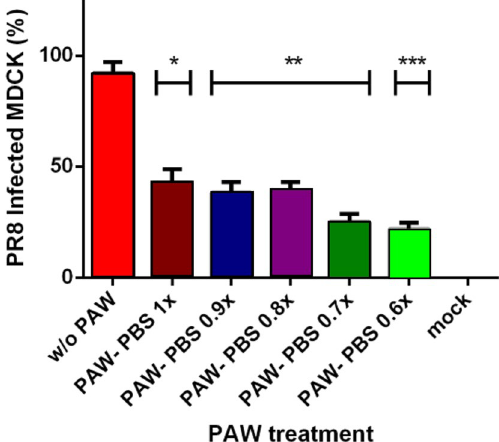
Figure 6. Counting of infected cells with PR8 without and with different PAW-PBS dilutions. Cells were infected with a MOI of 0.25 for 1 h, then submitted to the different treatments, and led the progression of the infection for 24 h. Immunofluorescence was carried out as described in methods and final counting of infected cells versus non-infected cells. Infection was reduced by more than a half (53%) with the lowest dilution of PAW-PBS used (90%PAW-0.1x PBS). Statistical analysis was carried out using unpaired t test (*p<0.05, **p<0.009, ***p<0.0004). Generated with INSKAPE 1.1 (www. inksc ape. org).